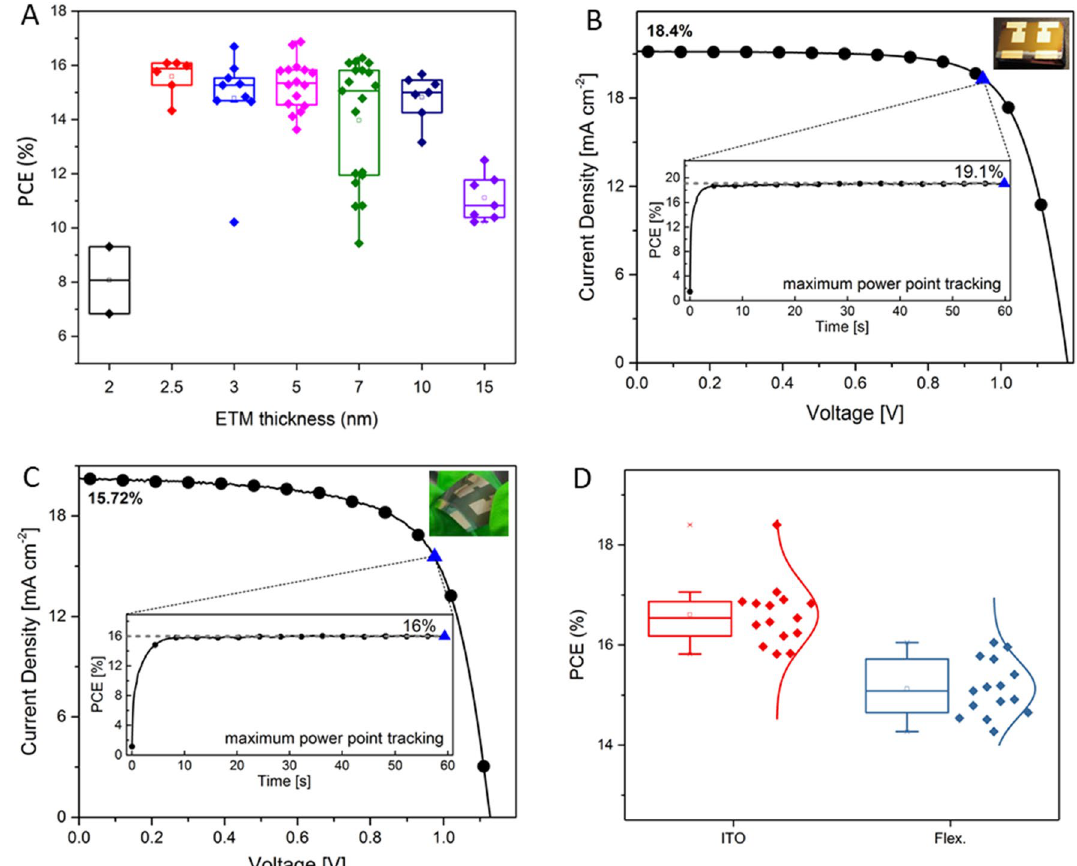
Figure 2. ( A ) Thickness optimization of the SnO 2 layer with at least 5 devices per thickness from 0 to 15 nm. We observe a decrease of reproducibility (out of 10 devices only 2 were working) for layer thicknesses less than 5 nm. ( B ) J-V curve of the best rigid cell on ITO with an additional thin PMMA layer between the perovskite and HTM. A stabilized PCE of 19.1% was achieved and 18.4% in the J-V scan. ( C ) J-V curve of the best flexible solar cell on PET/ITO with an additional thin PMMA layer. A stabilized PCE of 16.0% was achieved in the MPP measurement and 15.7% in the J-V scan. ( D ) Solar cell characteristics of 15 cells made on rigid and flexible ITO